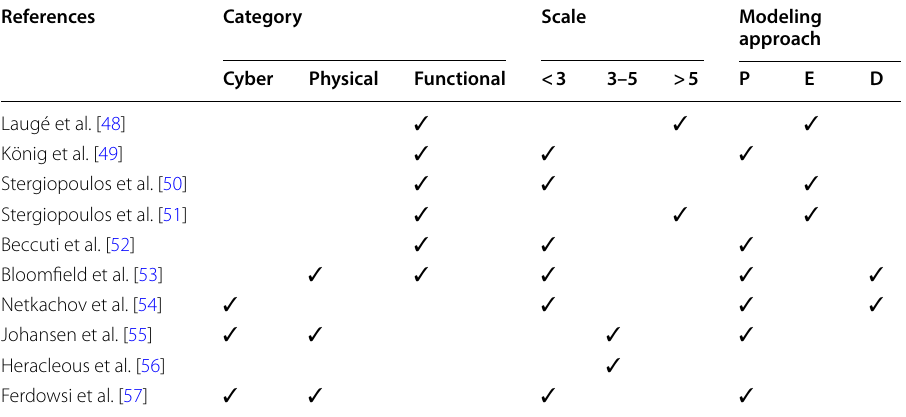
Table 5 Comparison of the methods modeling dependencies between smart cities’